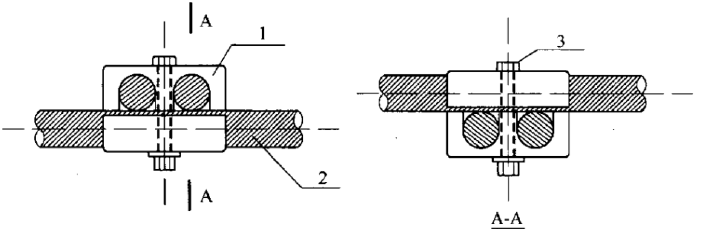
Figure 3. The joint for the LSHCS: 1. cable clamp, 2. spiral strand cable, and 3. fastening bolt [21].